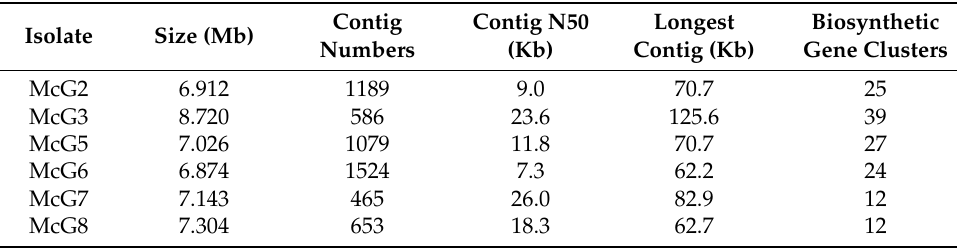
Table 4. Summary statistics of the genomes of Streptomyces isolates. Number of biosynthetic gene clusters is based on antiSMASH analysis.